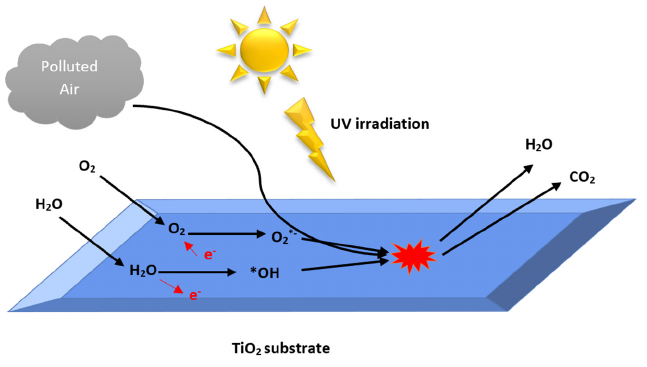
Figure 1. Polluted air photocatalysis treatment by TiO 2 .